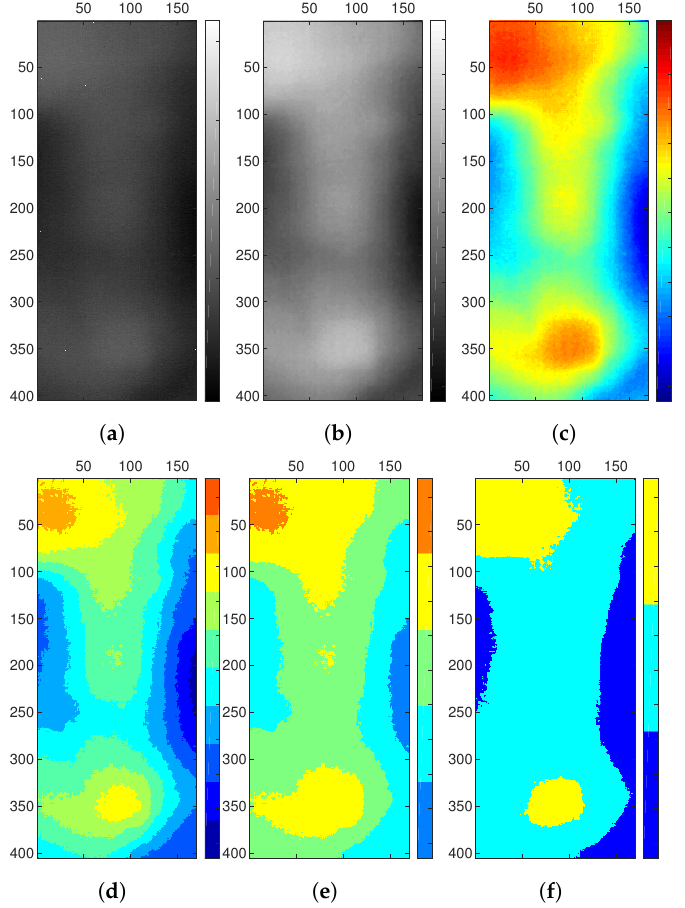
Figure 6. Impact of pre- and post-processing on image quality; experiment 1. ( a ) An example of the raw image. ( b ) The processed image. ( c – f ) Color mapping (64, 10, 5, and 3 levels).